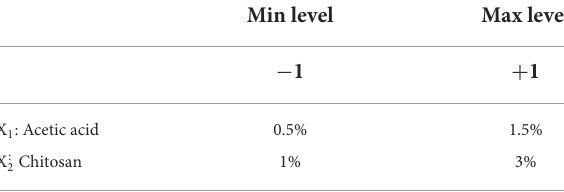
TABLE 1 Levels of factors (X 1 and X 2 ) involved in strawberries preservation.